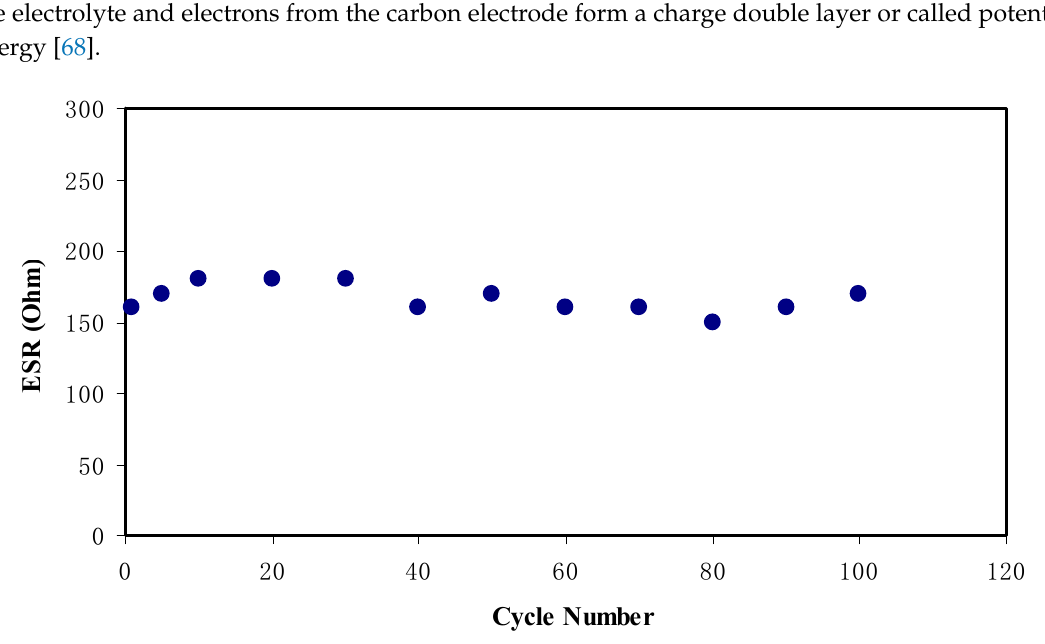
Figure 14. The pattern of equivalent series resistance of the EDLC for 100 cycles.